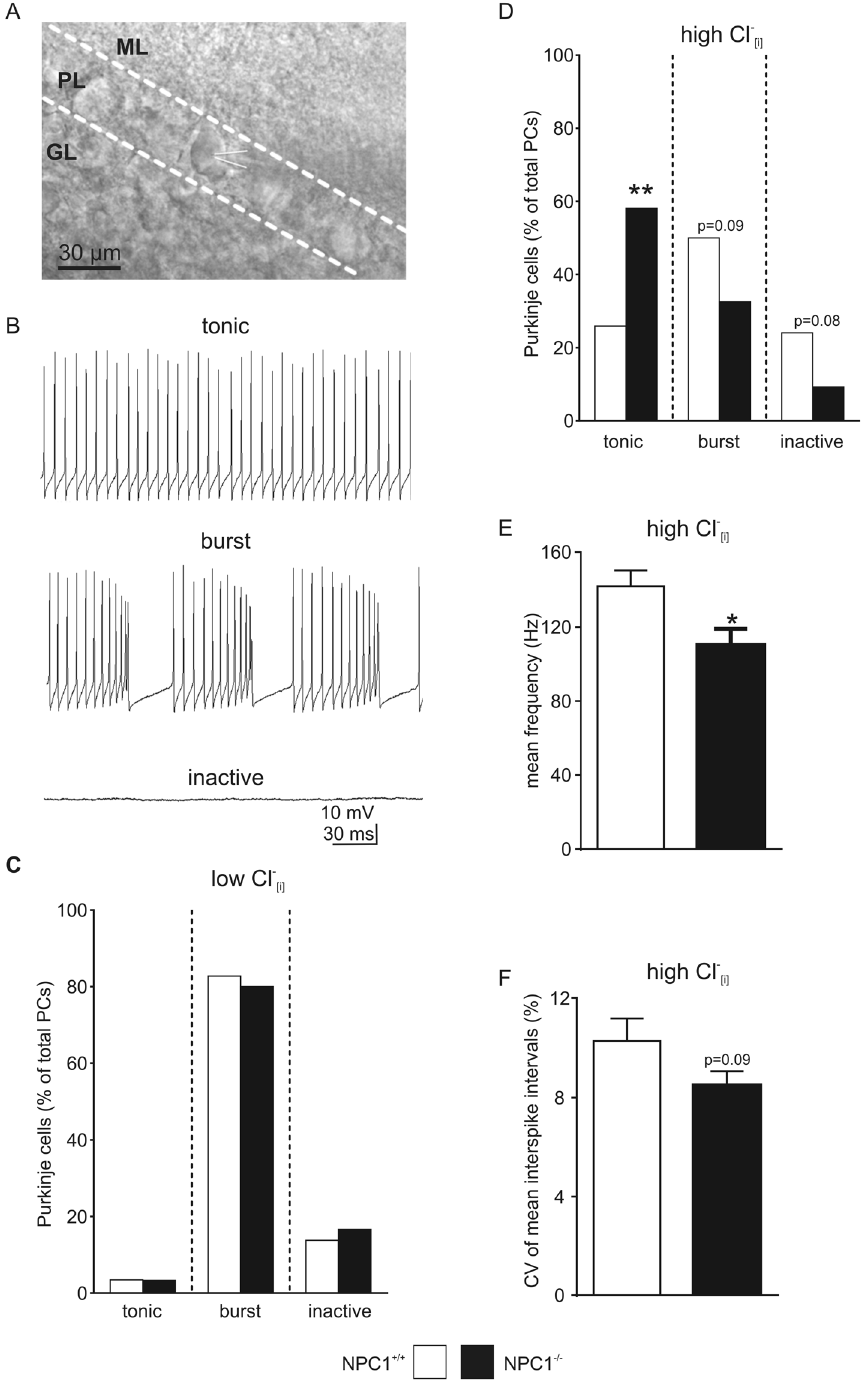
Figure 3. Chloride-dependent alterations of Purkinje cell activity pattern. ( A ) Optical identified PCs in lobes III-V were used for whole-cell patch clamp recordings. Recording electrode attached to PC is depicted by white lines. ( B ) Using the current clamp mode, three different activity patterns of PCs were found: tonic firing, burst firing and inactive. ( C ) No differences in pattern distribution between NPC1 + / + and NPC1 − / − mice were observed using a low Cl - [i] (NPC1 + / + : N = 11, n = 29; NPC1 − / − : N = 8, n = 30). ( D ) Significantly more tonic firing PCs were found in NPC1 − / − mice using a high Cl − [i] , whereas more PCs in NPC1 + / + mice showed burst activity or were inactive (NPC1 + / + : N = 19, n = 52; NPC1 − / − : N = 15, n = 43). ( E ) The tonic firing PCs of NPC1 − / − mice showed a significantly reduced action potential frequency and ( F ) a higher spike regularity using a high Cl - [i] (NPC1 + / + : N = 12, n = 14; NPC1 − / − : N = 11, n = 25). * p < 0.05, ** p < 0.01, data shown as mean ± sem. ML = molecular layer, PL = Purkinje layer, GL = granular layer. Barnard’s 2 × 2 test was used to determine significance for data shown in C and D. Student´s unpaired t-test was used to determine significance for data shown in E and